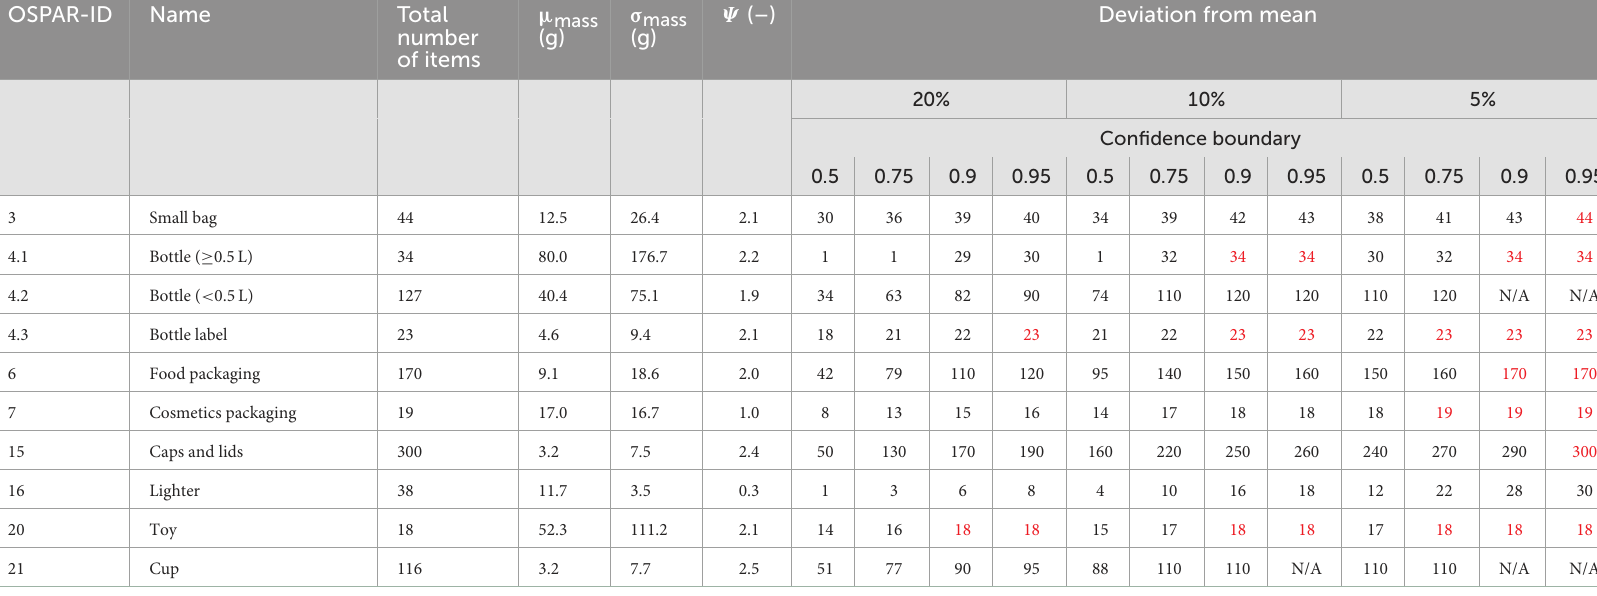
TABLE 2 Sample set size requirements (number of items) based on mean mass for a selection of categories in the study database with more than 10